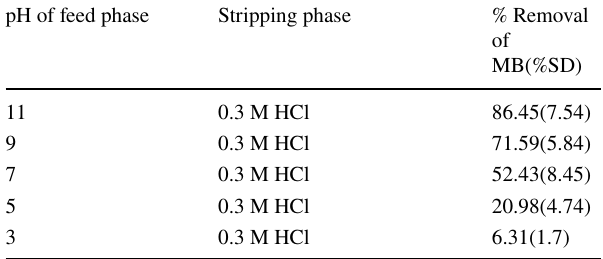
Table 5 Effect of Feed phase pH on the removal of MB